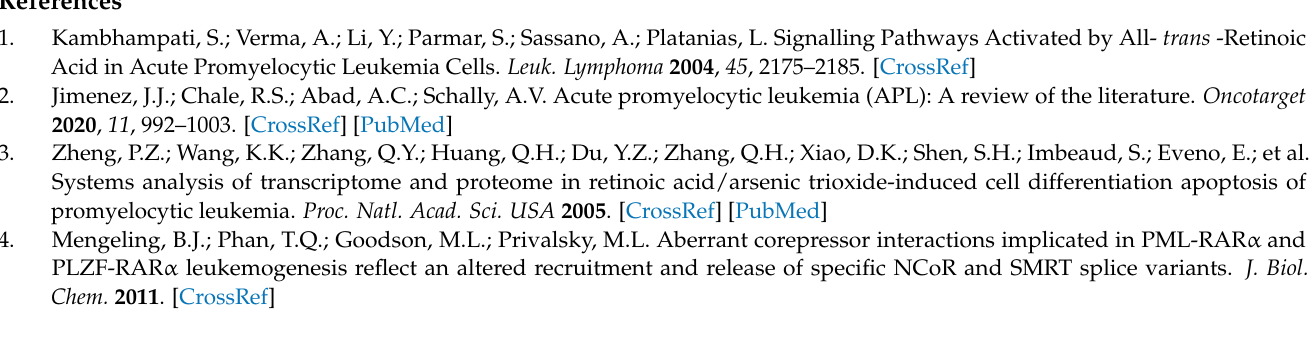
Table S8. Transition for SRM method (QqQ TSQ Vantage (Thermo Scientific,